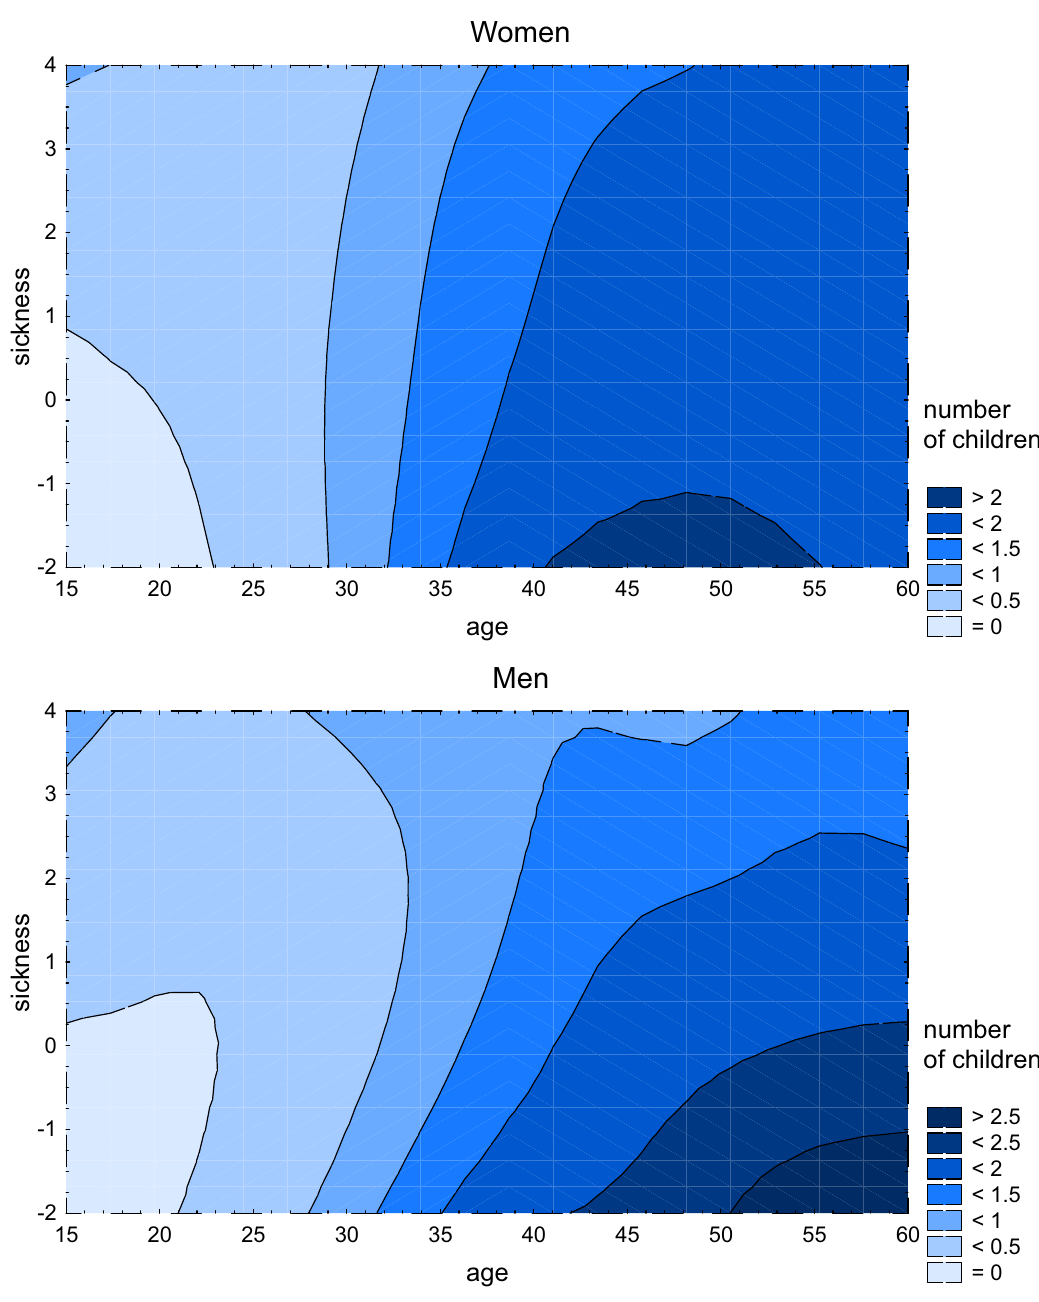
Figure 1. The effects of sickness index and age on the number of children in women and men. This figure shows XYZ contour plots with distance-weighted least-squares fitting used for extrapolation. If an interaction between the sickness index and age had no effect on the number of children, the differently coloured areas would form vertical